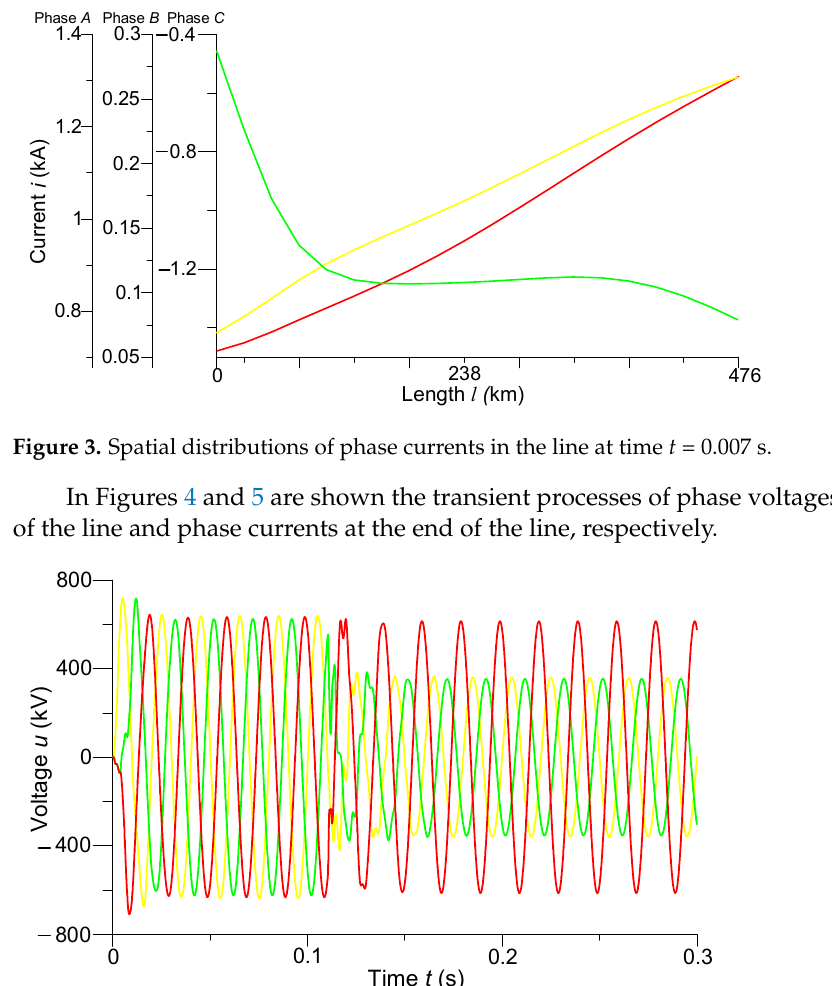
Figure 2. Spatial distributions of phase voltages in the line at time t = 0.001 s.